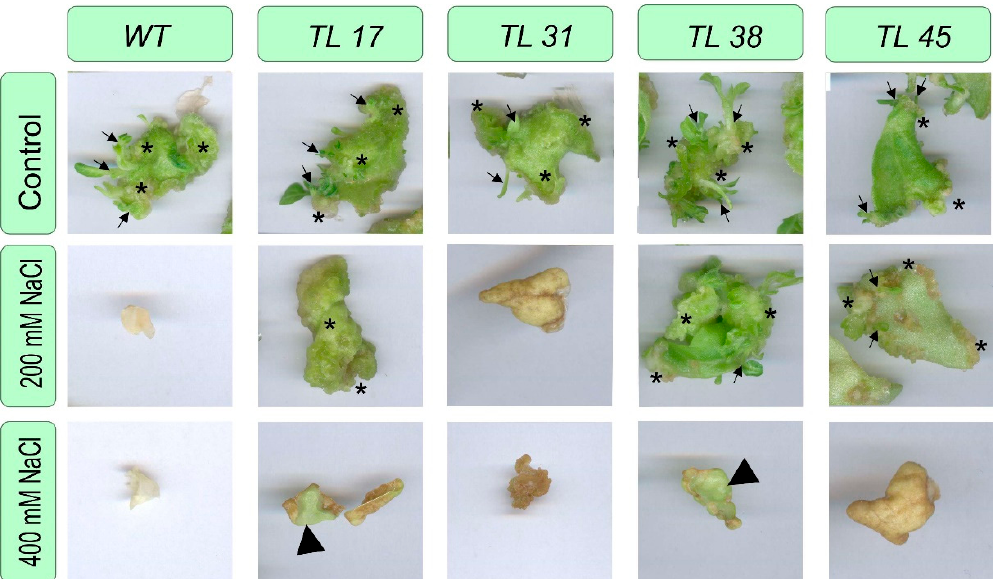
Figure 4. Determination of the in vitro morphogenic and callus forming ability of codA transgenic plants on Tm medium with an increased NaCl concentrations: WT—untransformed tobacco plants; TL17, TL38, TL45— codA independent transgenic lines. Legend: asterisk—callus; thin arrow—regenerant; large triangle—preservation of viable tissue with partial death cells in the explants.